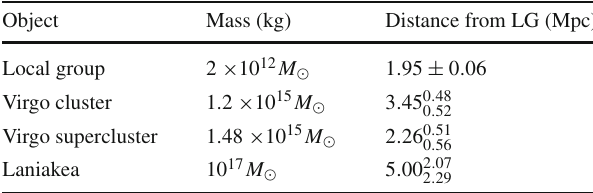
Table 2 Distances of objects where the density is ρ loc Object Mass